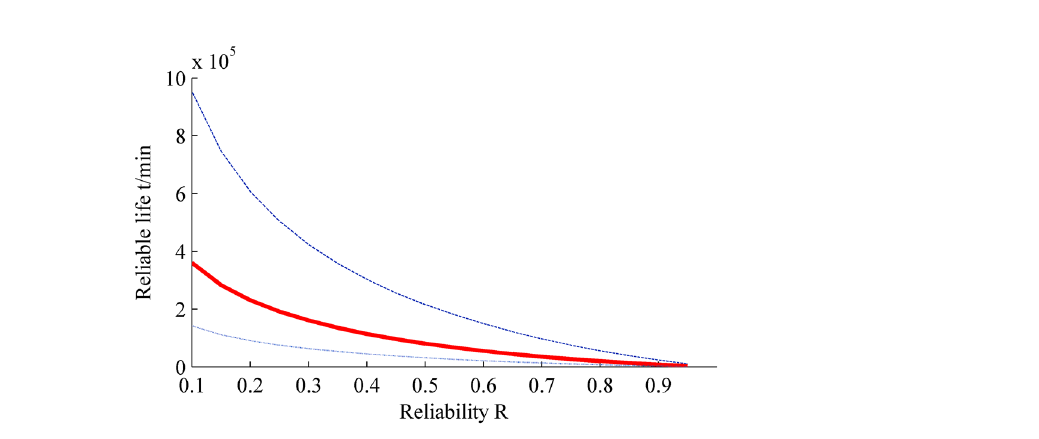
Figure 3. Interval estimation of reliability. Figure created using Matlab R2014a (https:// www. mathw orks. com).